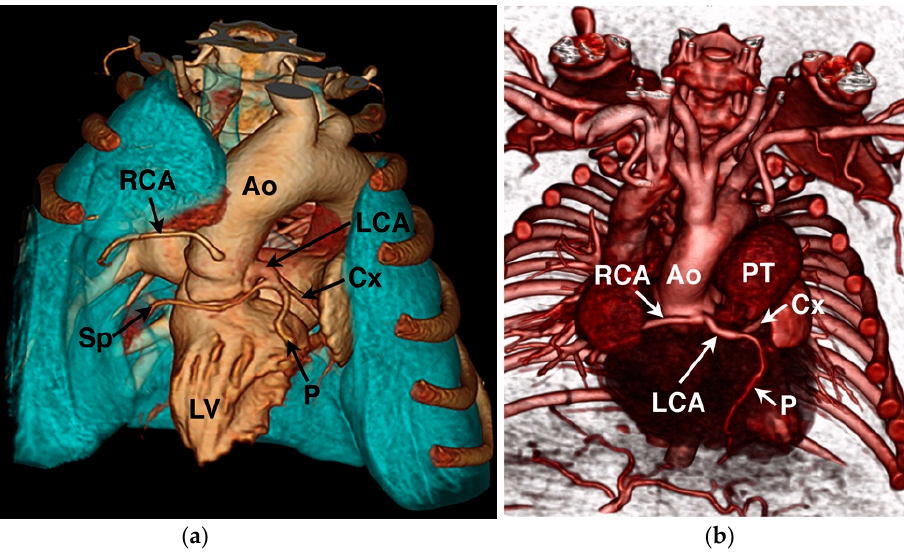
Figure 8. Computed tomography angiography examples of the coronary circulation from two different English bulldogs. ( a ) 3-dimensional volume-rendered reformat showing normal coronary artery anatomy. Ao = aorta, Cx = circumflex branch, LCA = left coronary artery, LV = left ventricle, P = paraconal interventricular branch, RCA = right coronary artery, and Sp = septal branch. ( b ) 3- dimensional volume-rendered reformat showing a single right coronary ostium with prepulmonary left coronary artery encircling the pulmonary valve annulus in a dog with concurrent pulmonary valve stenosis. PT = pulmonary trunk Coronary artery stent-angioplasty, surgical unroofing of an intramural coronary segment, or osteoplasty to create a new opening in the appropriate valvar sinus are treatment strategies in